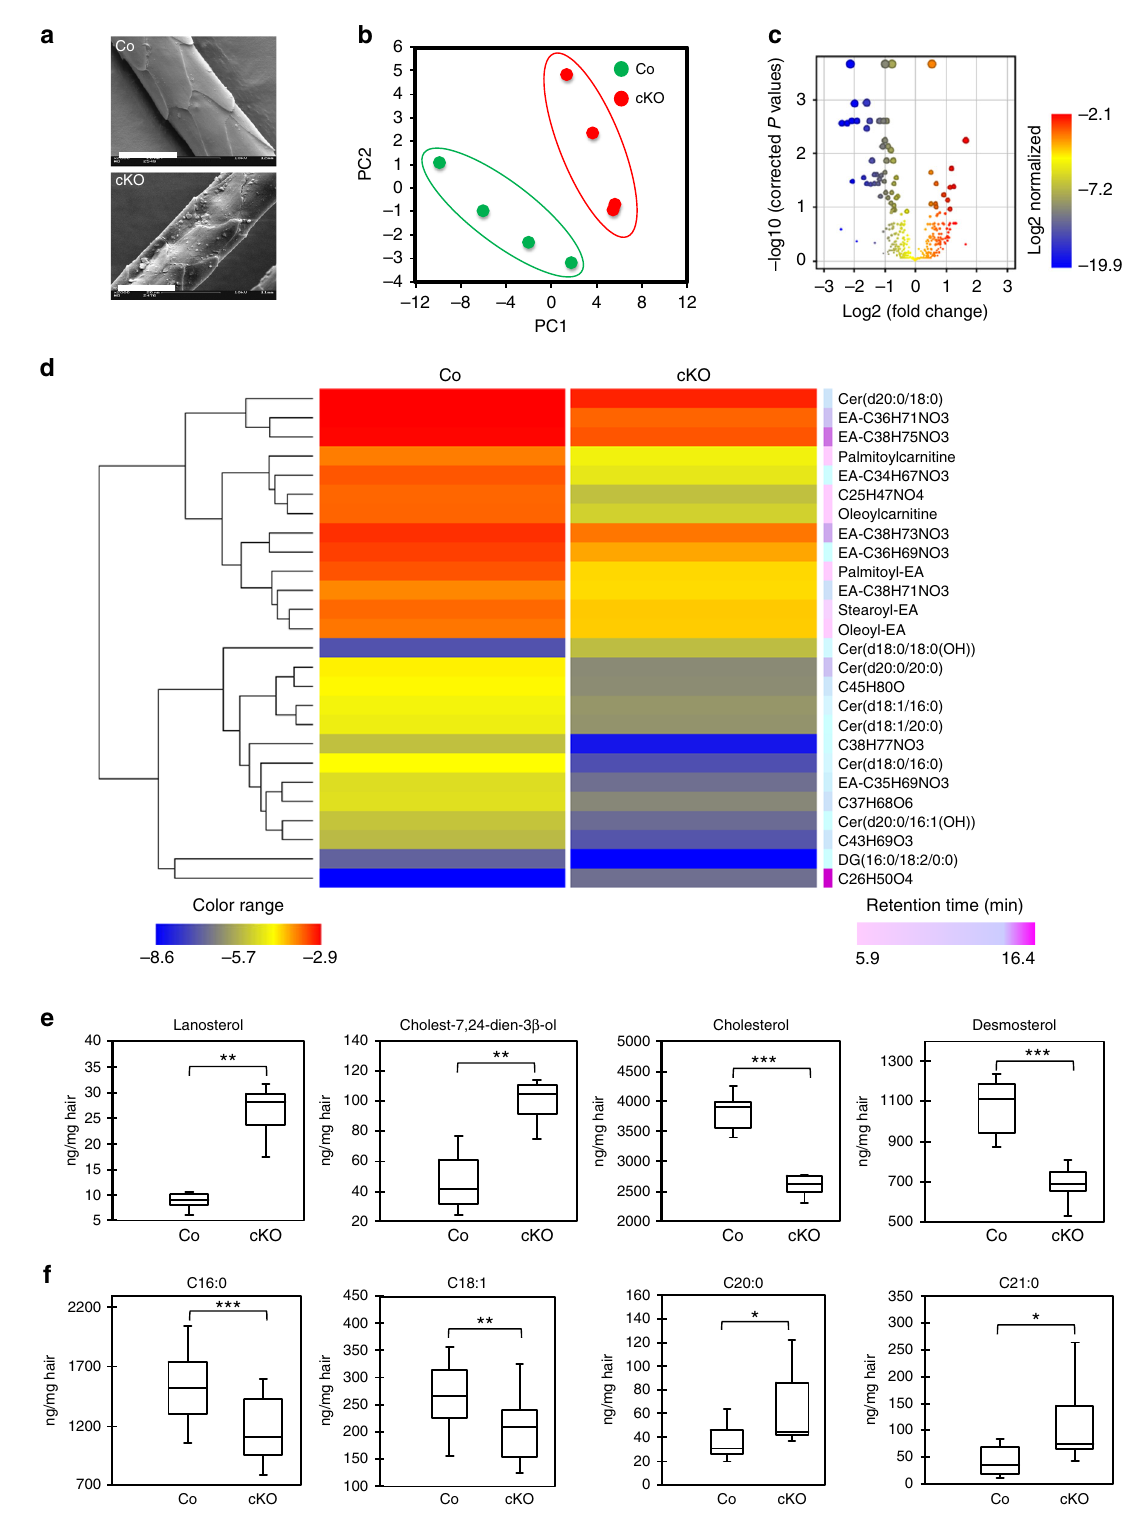
Fig. 5 Substantially altered sebum components in JunB cKO hairs. a Scanning electron microscopic images demonstrate irregular hair architecture with a rough carved surface in JunB cKO mice, magni fi cation 2000×. Scale bars, 50 µ m. b Principal component analysis (PCA) illustrating the variances between the different sample groups. c Volcano plot displaying signi fi cantly changed lipid species between wild type and JunB cKO mice hair extracts. Color scale re fl ects Log 2 normalized values. d Integrated heatmap analyses of signi fi cantly changed lipid species between wild type and JunB cKO mice hair extracts. Color scale (blue to red) re fl ects Log 2 values and color scale (pink to purple) shows retention time in the LC-MS analysis indicated in minutes. e GC-MS analyses of hair extracts from adult wild type and JunB cKO mice depicting lipid species involved in cholesterol biosynthesis or f different classes of free fatty acid. * P < 0.05, ** P < 0.01, *** P < 0.001 ( n = 3), t-test. Upper border of box depict 3rd quartile, while lower border depict 1st quartile. The midline represents the median value and the whiskers represents the maximum and minimum